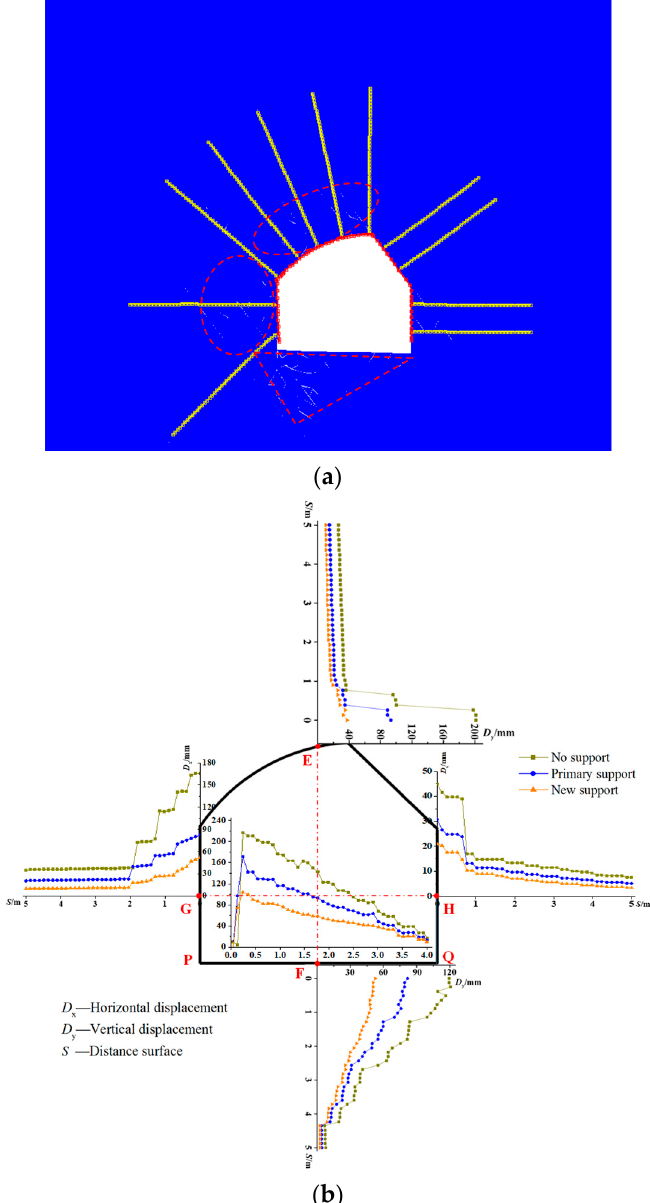
Figure 15. Maintenance and control effects of the roadway under the new support. ( a ) Distribution characteristics of cracks; ( b ) evolution law of the displacement of the roadway’s surrounding rocks with depths under different supports.